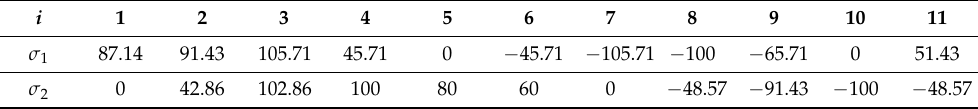
Table 1. Experimental data of the initial transformation onset of Cu-Al-Be SMA at 35 ◦ C (unit: